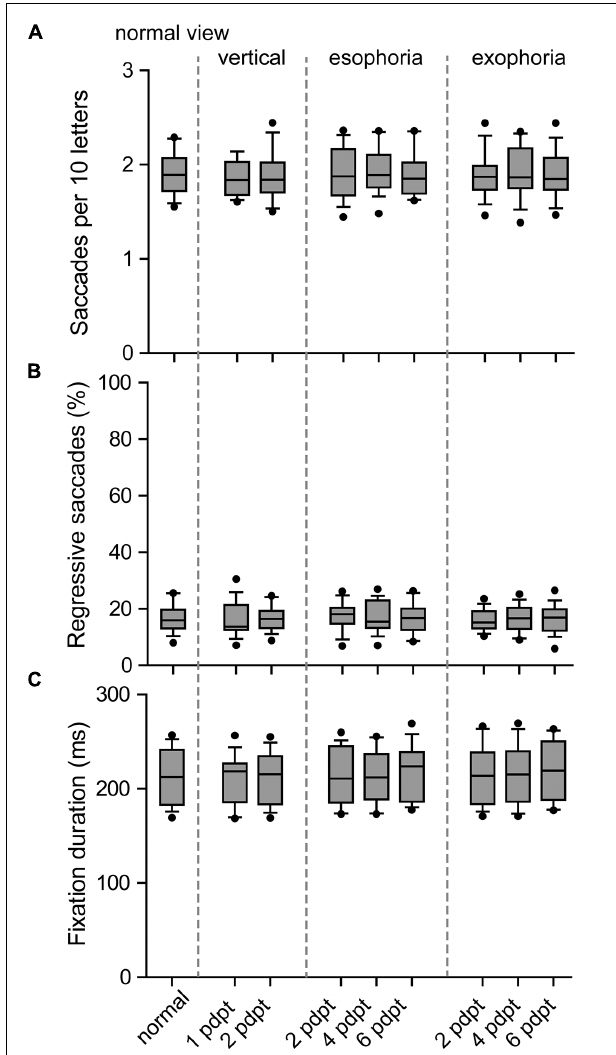
FIGURE 2 | Eye movements during reading with prisms. Boxplots for number of saccades per 10 letters (A) , proportion of regressive saccades (B) , and average fixation duration (C) .The boxes contain the mean and 50% of the data, and the whiskers indicate 10/90% of the